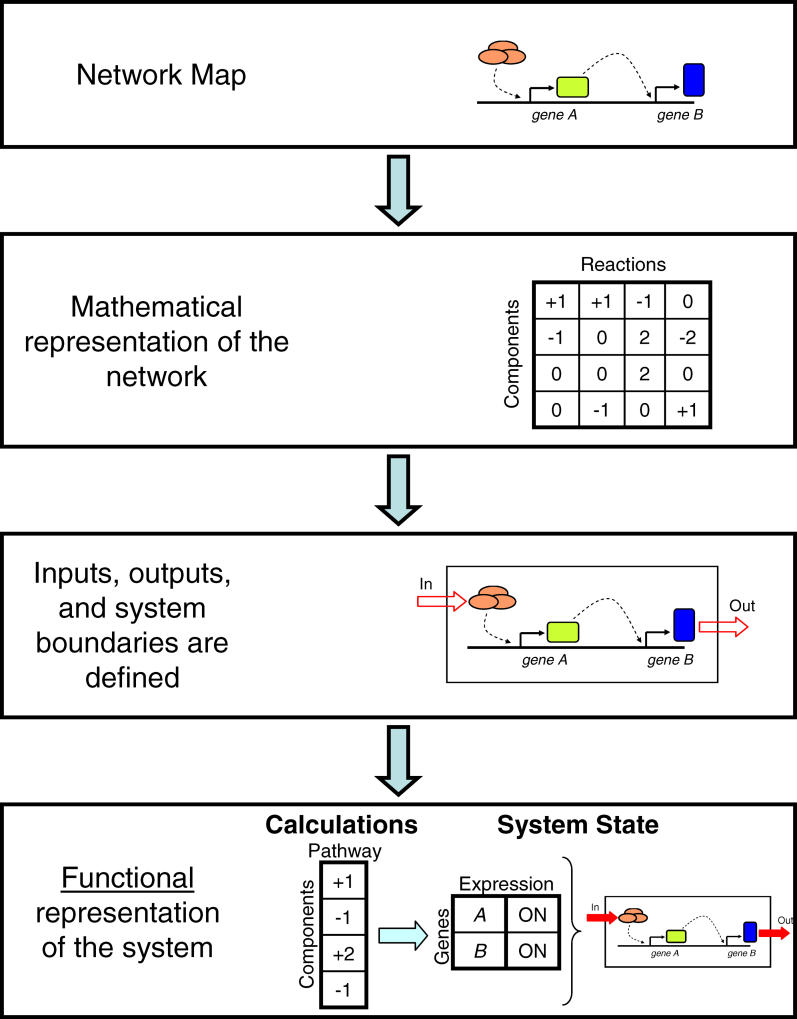
Toward a Functional Description of a Biological SystemThe general process of connecting a network map to a functional description of the network is depicted. A network is comprised of components and the interactions between them, and it is often graphically displayed as a map. This map is in turn represented mathematically as an incidence matrix that captures the stoichiometry of the underlying chemical transformations of the network. Subsequently, the boundaries of the network and its inputs and outputs are delineated, yielding a complete system. Finally, matrix analysis techniques are used (e.g., extreme pathway analysis) to generate functional descriptions of system properties (e.g., system states).